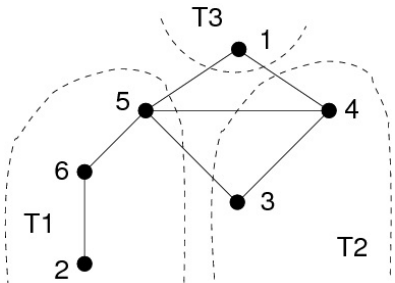
Figure 5 . This MNS ordering does not number slices in increasing order on this chordal graph. (The MNS labels are sets of numbers of neighbors, and set comparison by ⊆ is not a total